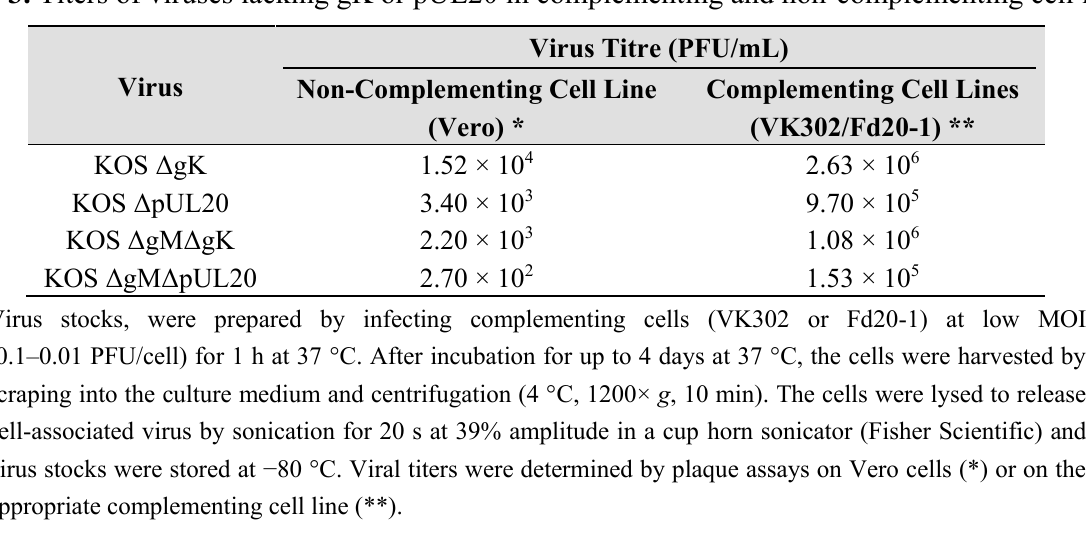
Figure 2. Schematic representation of recombinant viruses constructed. ( a ) Representation of the prototypic arrangement of the HSV-1 genome with the unique long (U L ) and unique short (U S ) regions flanked by the terminal repeat (TR) and internal repeat (IR) regions; ( b ) Relative genomic positions of genes mutated to create recombinant viruses; ( c ) Schematic representation of mutations created. Viruses lacking gM, gK, and pUL20 were constructed by replacing codons 53–55, 54–56, and 20–22 with three stop codons in the U L 10, U L 53, and U L 20 genes, respectively. Table 3. Titers of viruses lacking gK or pUL20 in complementing and non-complementing cell